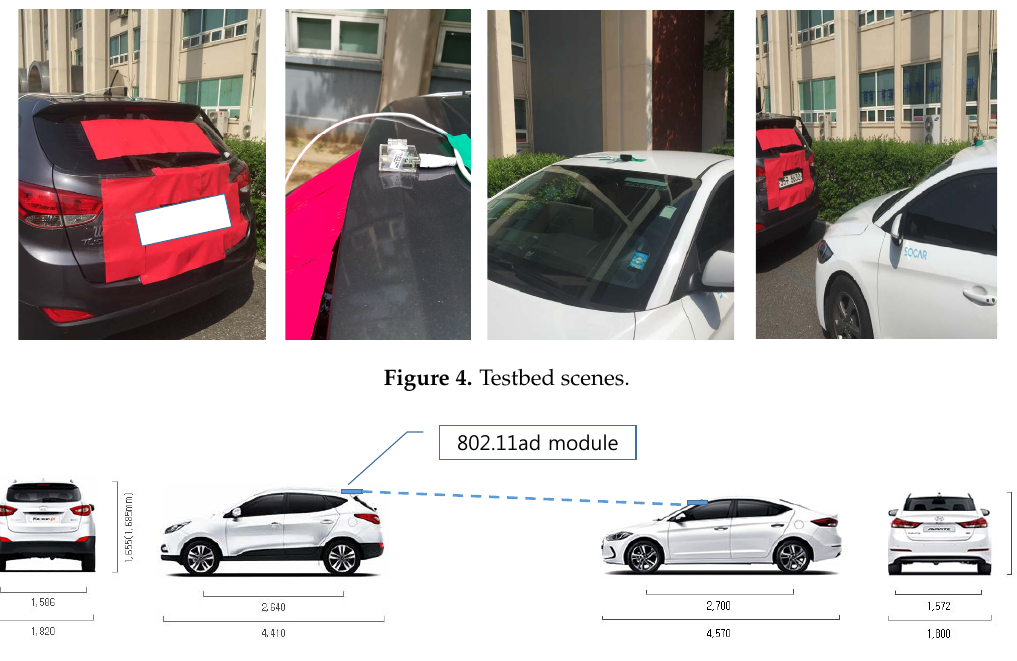
Figure 5. IEEE 802.11ad module installation on vehicles